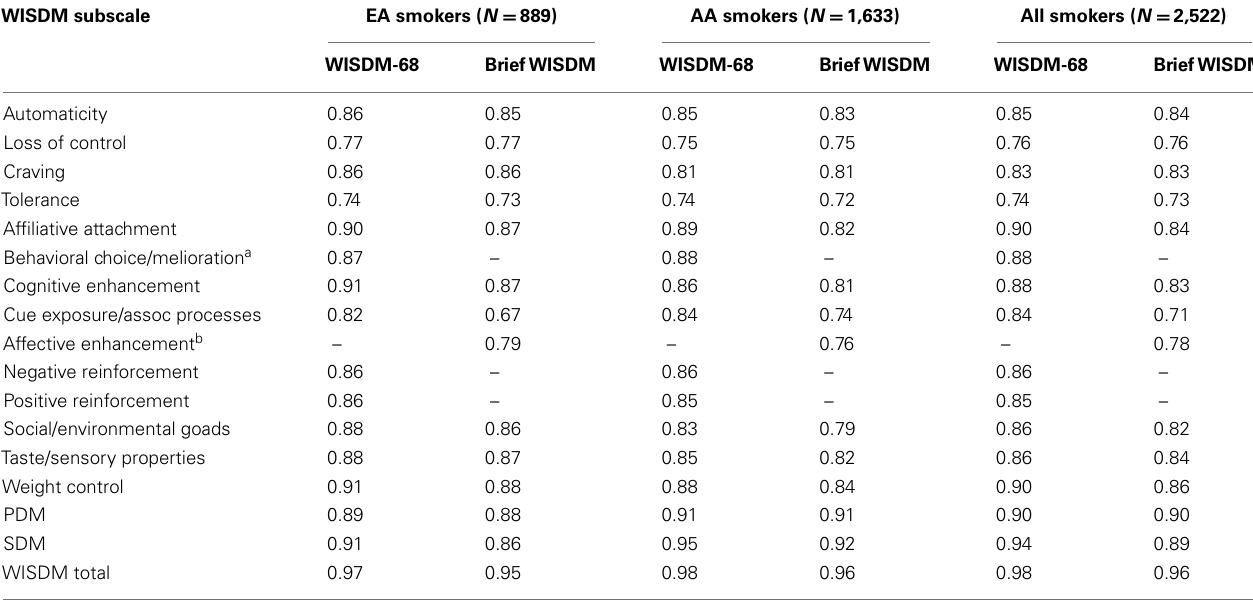
Table 2 | Internal consistency ofWISDM-68 and briefWISDM